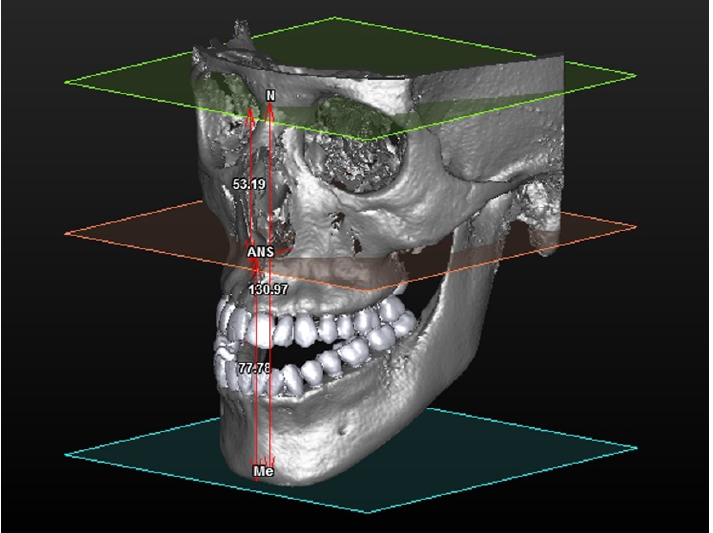
Figure 4. 3D rendering of a subject resulting from “Dolicocephalic” analysis. Table 7. Identification of intervals regarding the spatial evaluation of the upper jaw with respect to the plane coursing the Anterior Nasal Spine (ANS). This spatial value is defined as Maxilla (MX).